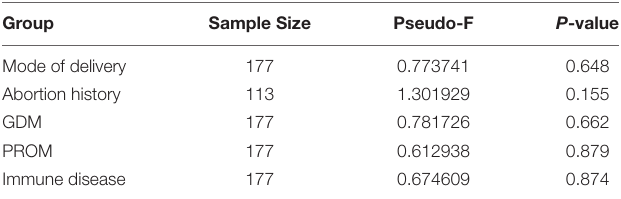
TABLE 2 | Beta-diversity between different groups based on pairwise permanova results of Bray–Curtis